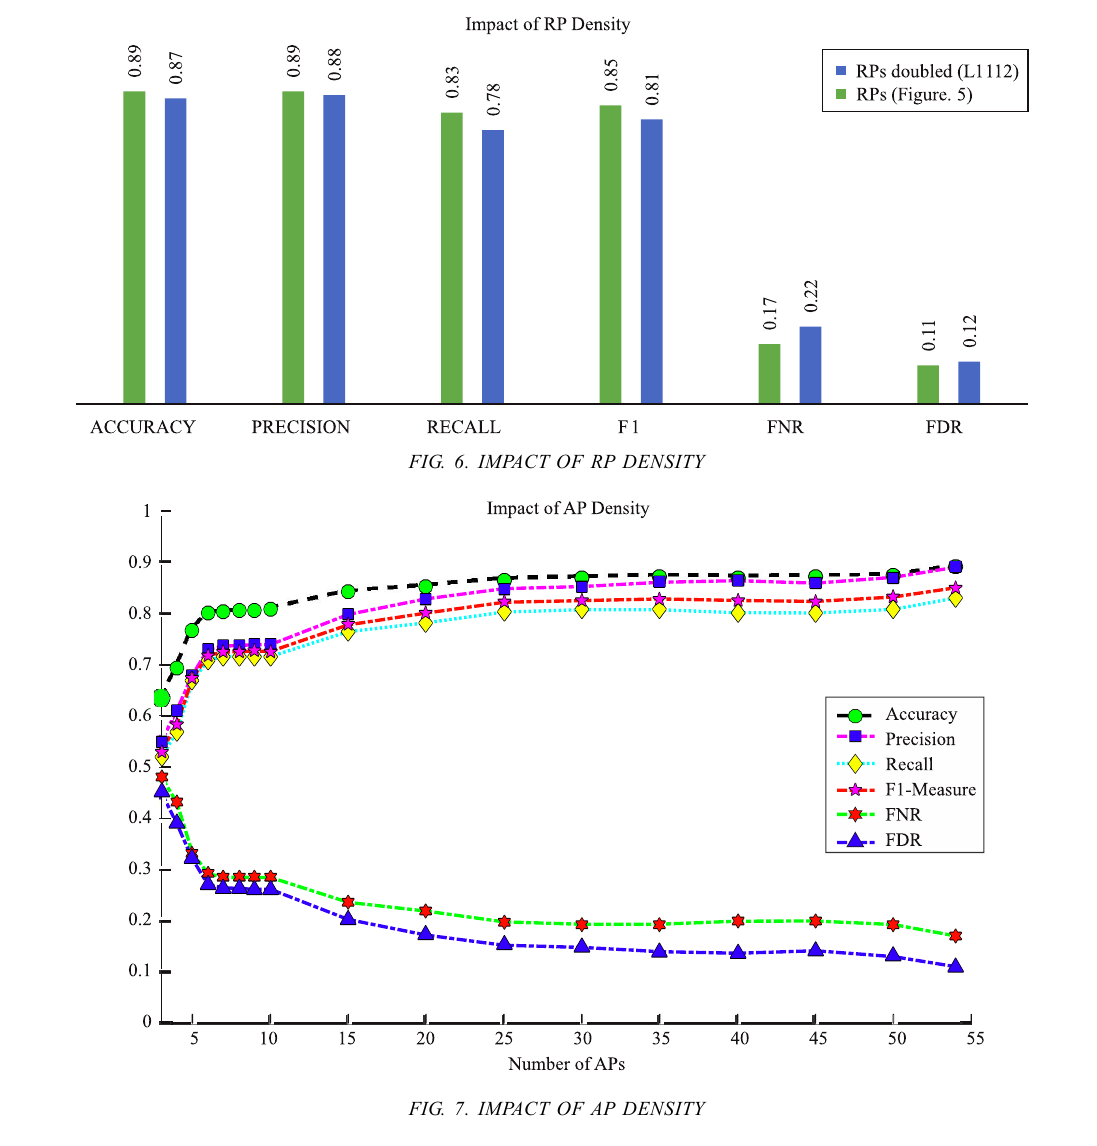
FIG. 7. IMPACT OF AP